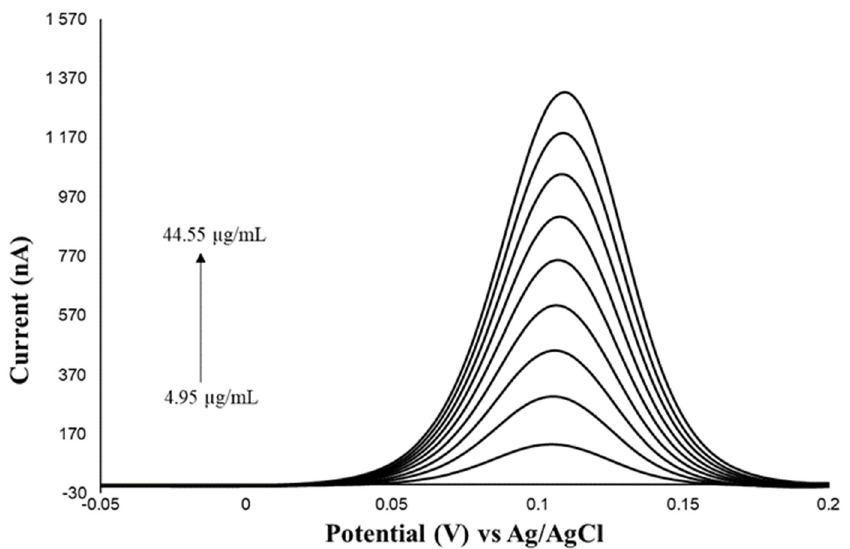
Figure 5. Voltammograms of standard solutions of ascorbic acid plotted for concentrations ranging within 4.95 − 44.55 μ g/mL.